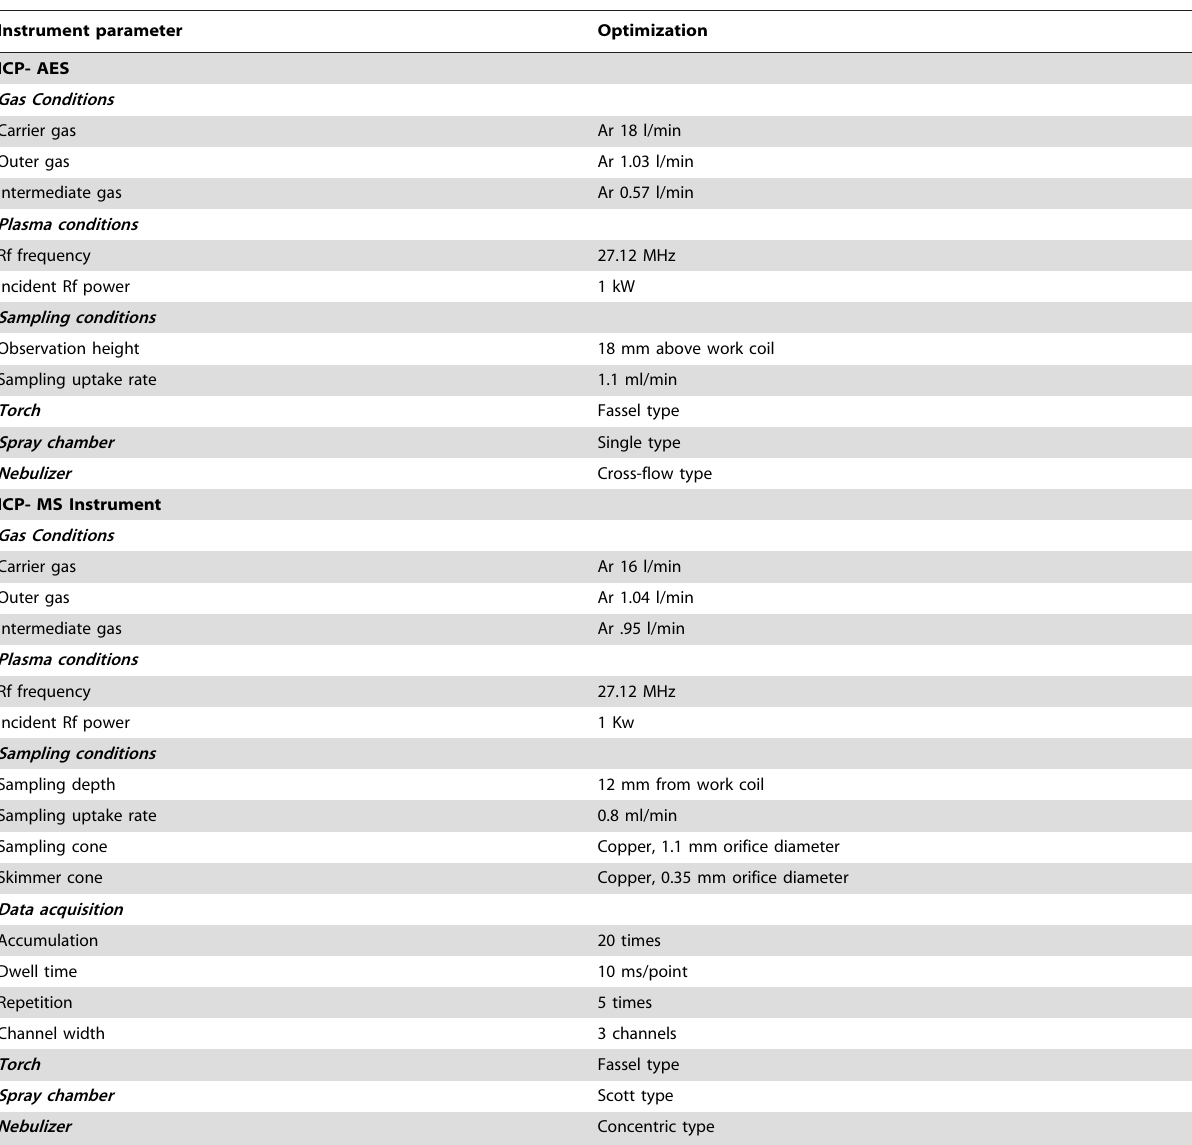
Table 5. The ICP instrumental and operating